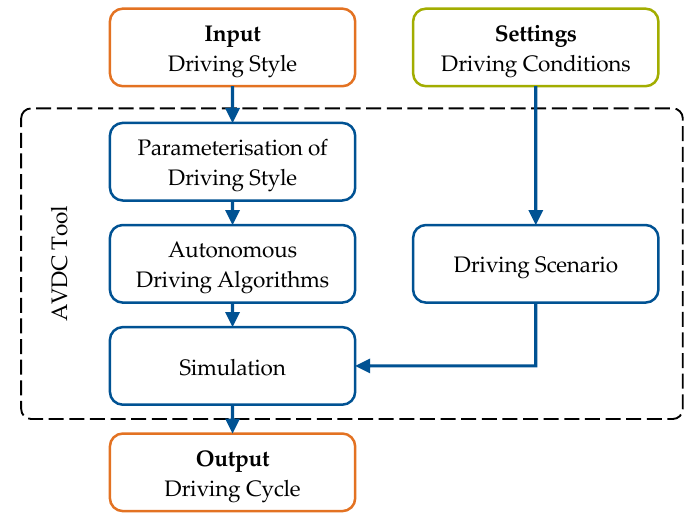
Figure 2. Structure of the AVDC Tool.